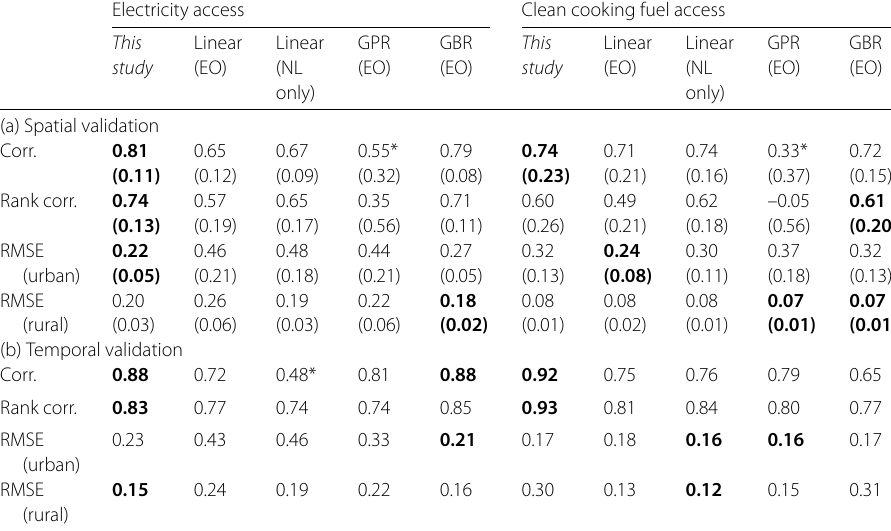
Table 2 (a) Spatially cross validated (CV) results for energy access at microregions for 2013 and comparison with existing works. (b) Temporally validated nowcasts for 2020 with DHS-2019 data aggregated at regions and comparison with existing works. Corr. refers to Pearson’s r correlation, Rank corr. refers to Spearman’s rank correlation and RMSE refers to Root Mean Square Error, which is disaggregated by urban and rural areas. The target values are normalized between 0 and 1. The p -values for all targets is less than 0.001, unless annotated with a ‘*’. RMSE is in same units as the target, with lower values indicating a better fit. The columns highlighted Linear (EO) and Linear (NL) are comparative methods, where the former denotes a linear model with our covariates and the later denotes a linear model with only nighttime lights data. Results for past approaches on all covariates are reported in columns GPR (Gaussian Process Regression [12]) and GBR (Gradient